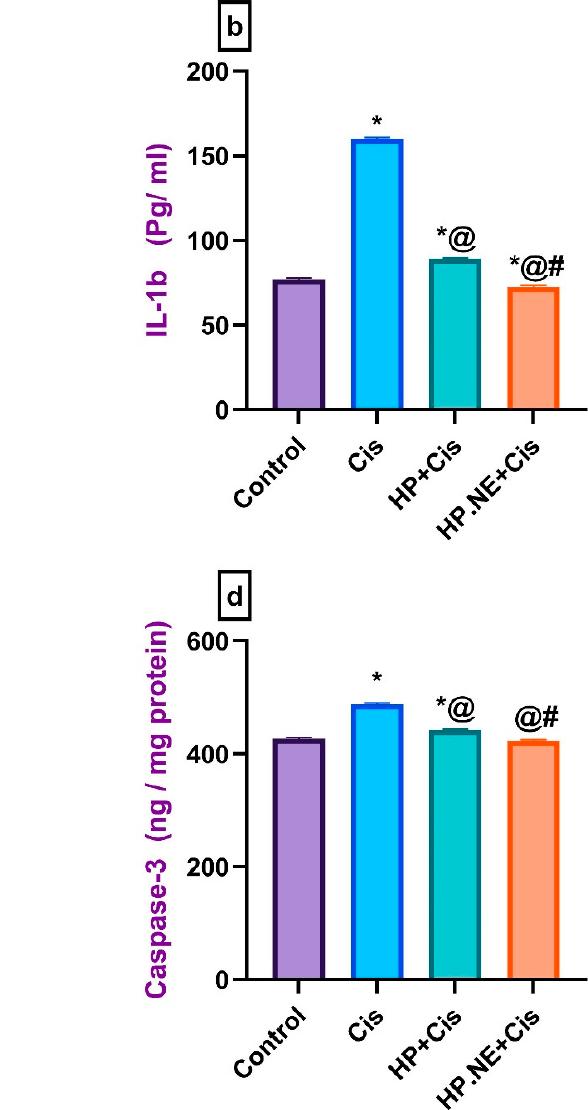
Figure 5. Effect of HP L. and HP.NE administration on the brain levels of pro-inflammatory cytokines in different groups. ( a ) IL-6: interleukin 6, ( b ) IL1b: interleukin-1 beta, ( c ) TNF α : tumor necrosis factor α , and ( d ) Caspase-3. Data are expressed as mean ± SE (one-way ANOVA) followed by Tukey’s post hoc test for seven rats in each group. * means significant from the Control group; @, significant from the Cis group; #, significant from the HP + Cis group.